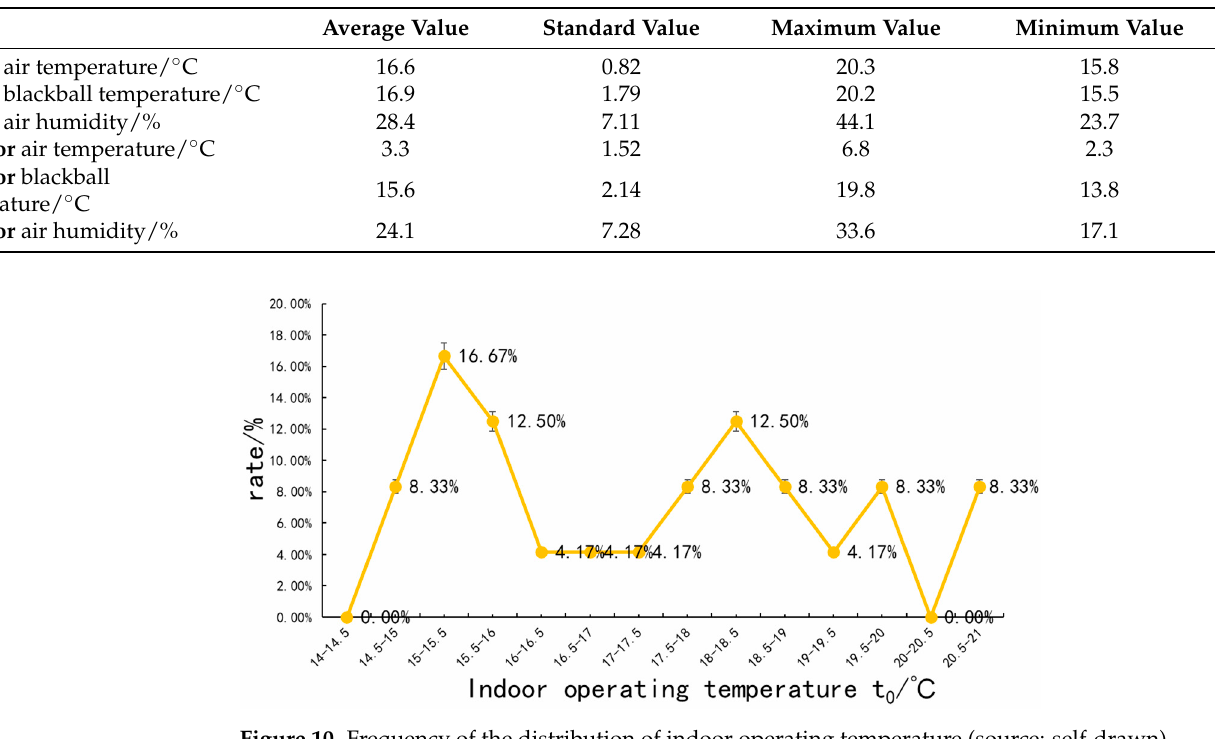
Table 3. Indoor and outdoor thermal environment parameters.